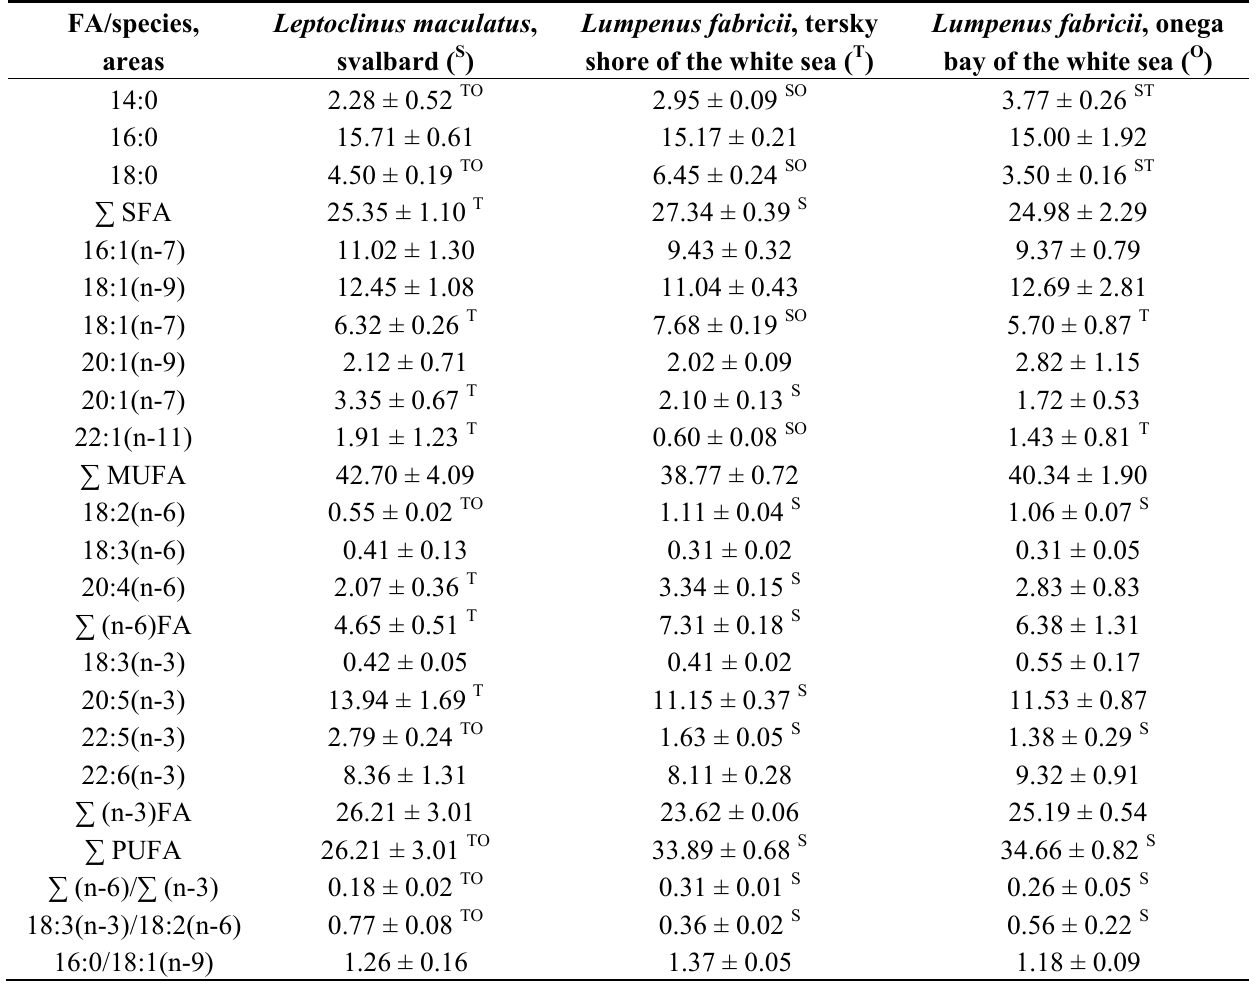
Table 2. Fatty acid (FA) spectrum (% of total FA) in flesh of Leptoclinus maculatus from Svalbard (Isfjord) and Lumpenus fabricii from the White Sea (Onega Bay and Tersky Shore).